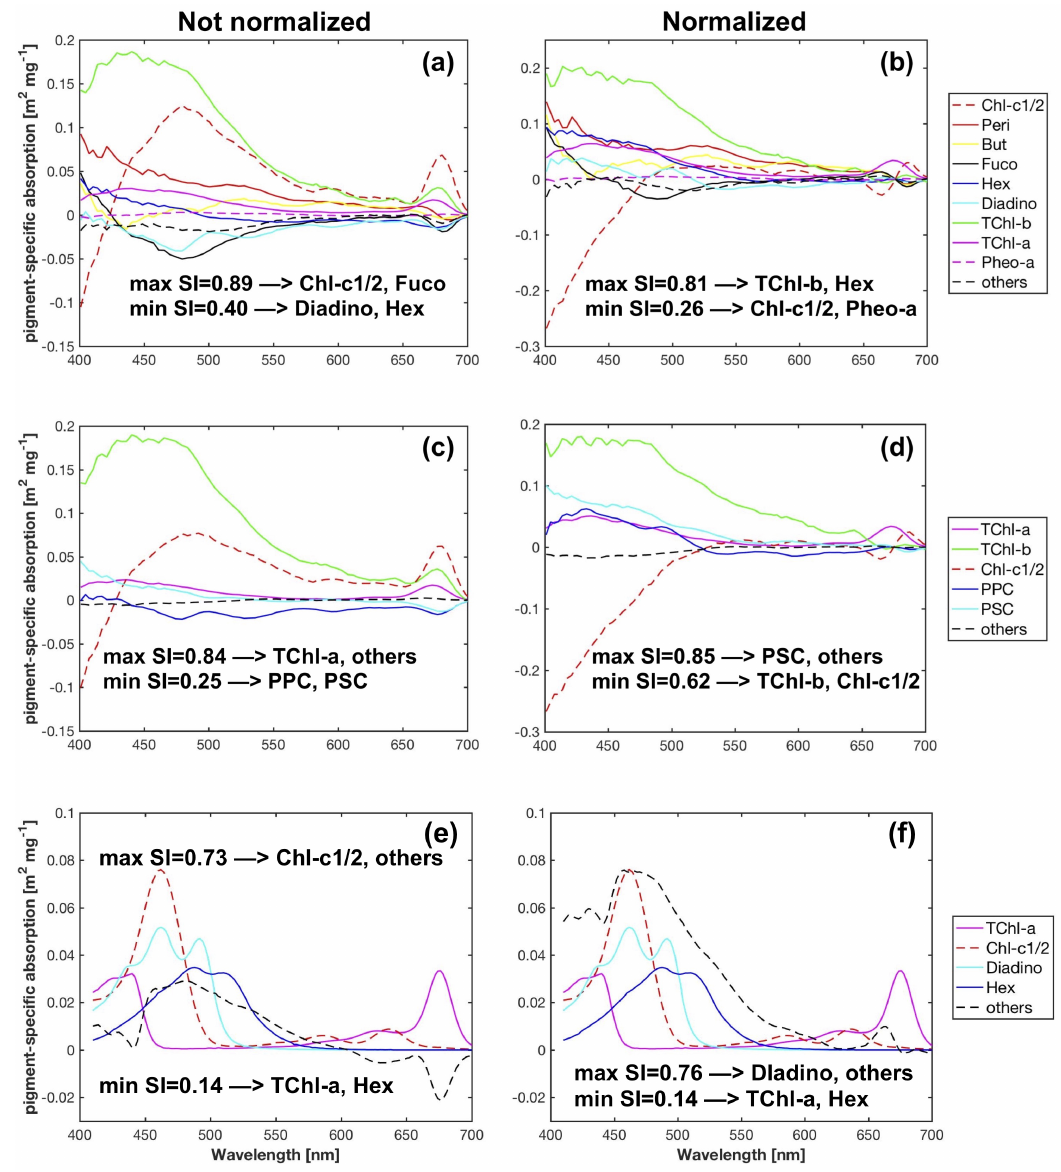
Figure 7. Pigment-specific absorption spectra obtained from SVD-NNLS-9 ( a , b ), SVD-NNLS-5 (cid:48) ( c , d ) and Bricaud-SVD-NNLS-4 ( e , f ) without data perturbations, respectively. Cases with and without package effect normalization were